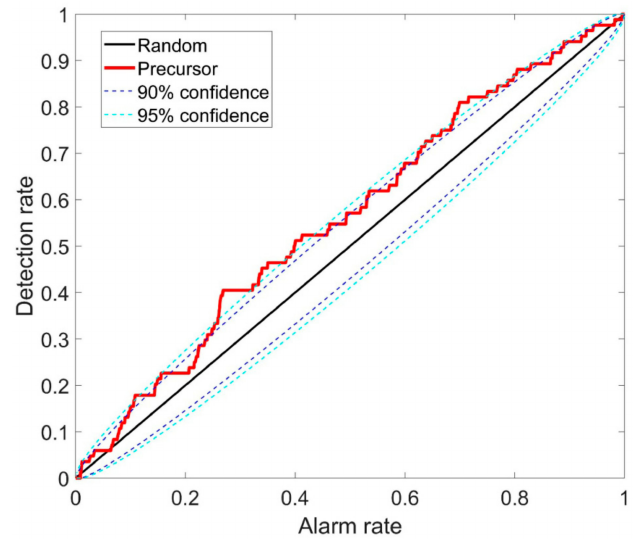
Figure 11. The Molchan’s error diagram of the optimal prediction strategy based on the observations (lead time = 1 day and alarm window = 3